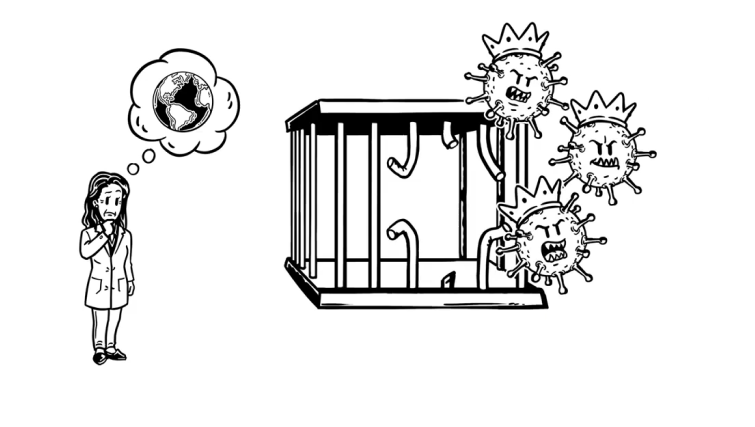
Figure 3. Example for an animation video: Channel simpleshow on